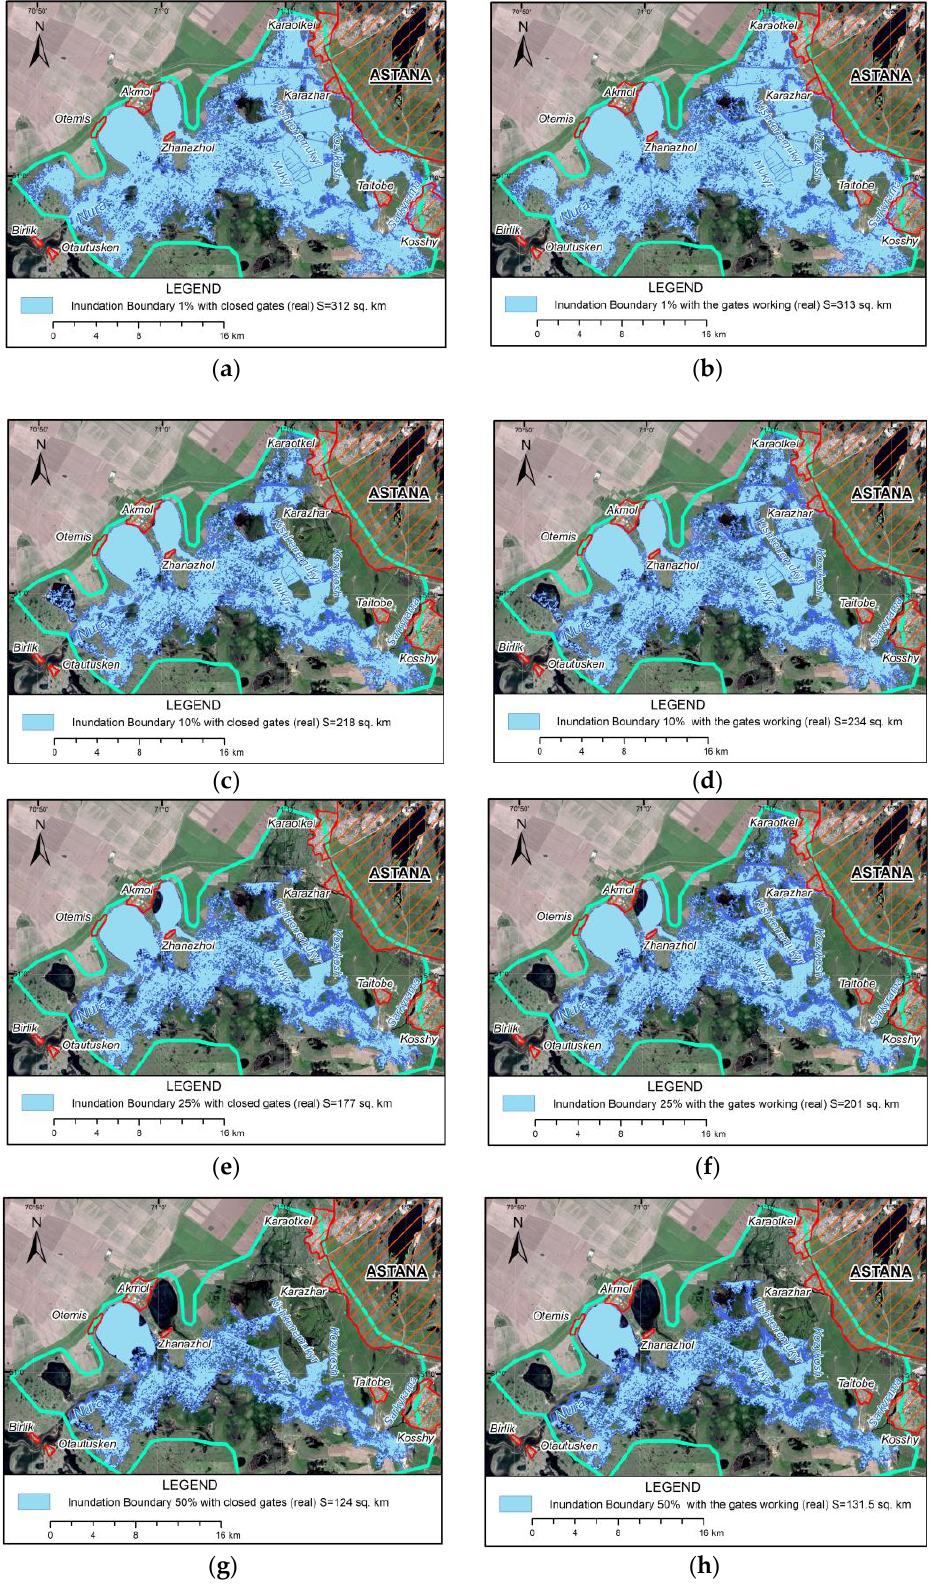
Figure 10. Flood inundation area during spring floods of different exceedance probability: 1% ( a , b ), 10% ( c , d ), 25% ( e , f ), 50% ( g , h ) with closed gates and with operating gates.